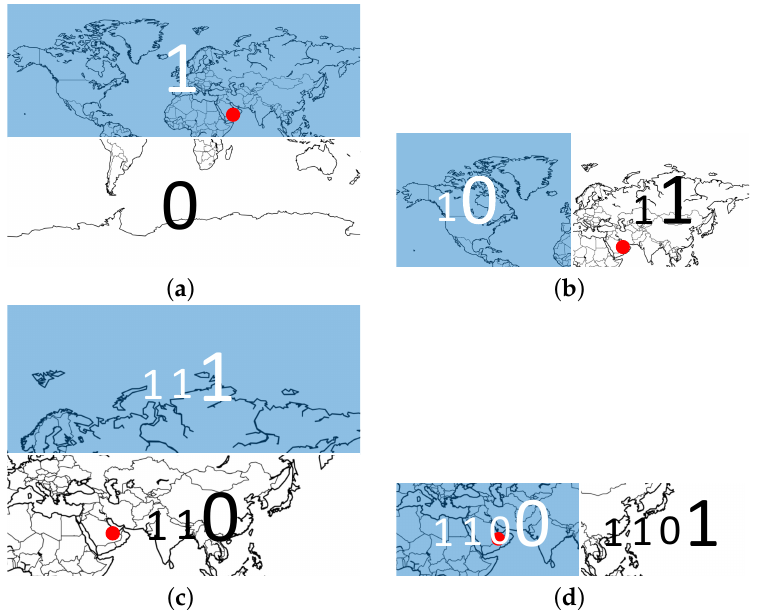
Figure 4. Illustration of the geohash’s first coding stage. A location (the red circle) in North Africa is our reference point. Starting with the latitude axis, we can divide the global latitude interval [ 90 ◦ , + 90 ◦ ] into two parts using the equator ( a ). The red circle falls in the latitude interval [ 0 ◦ ,90 ◦ ] . − This region is colored in deep blue and marked as bit ‘1’. The other part is dubbed ‘0’. Then, in ( b ), the same partitioning is repeated for the longitude interval [ 180 ◦ , + 180 ◦ ] . Since the red circle is − located in the deep blue area, we obtain a code of two bits ‘11’ after the second division. As shown in ( c , d ), this is repeated until the code reaches the demanded length. All the odd bits are generated by latitude coordinates, while the even bits are generated by longitude